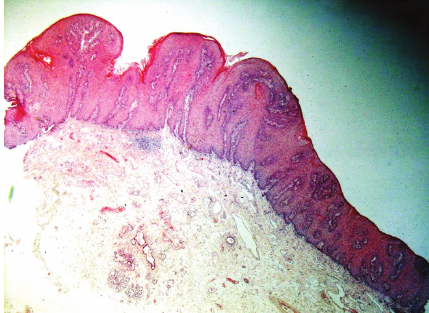
Figure 3: Photomicrograph of verrucous hyperplasia showing blunt surface projections (original magnification 4x, H and E